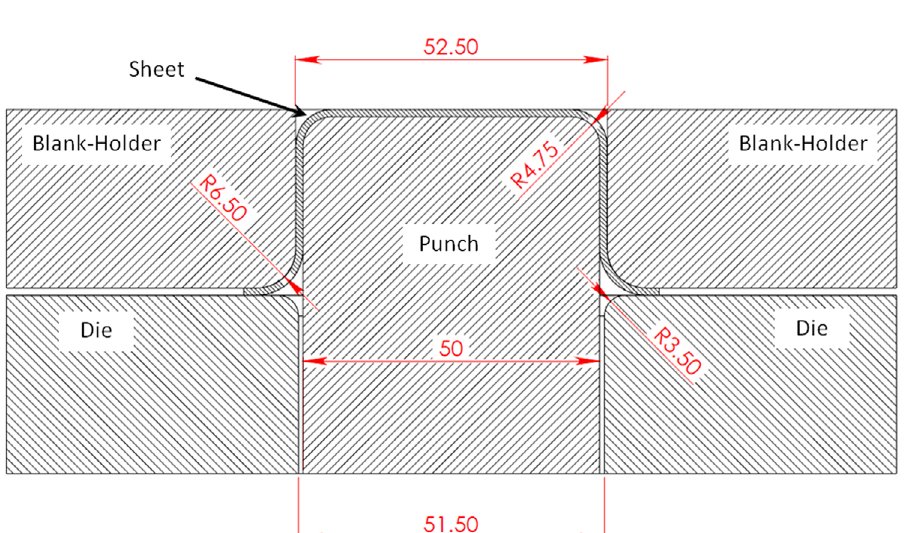
Figure 3. Section view of the stamping test tooling (dimensions in